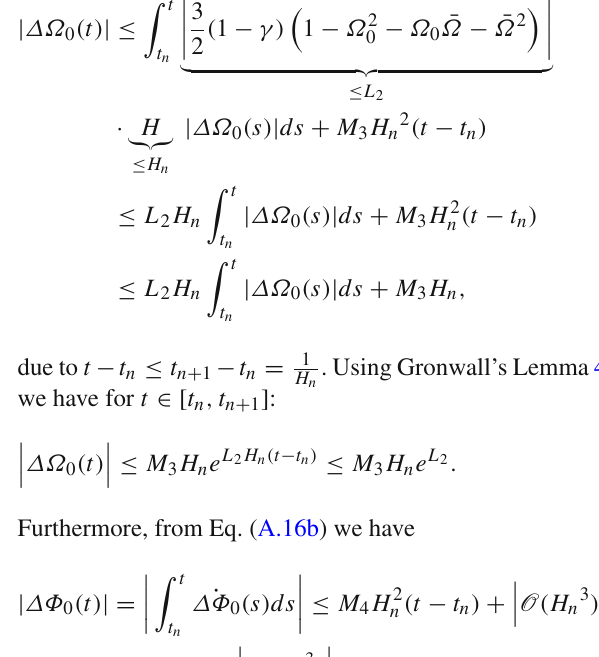
Table 3 Seven initial data sets for the simulation of full system (44) and averaged system (72) for Bianchi I metric are displayed. All